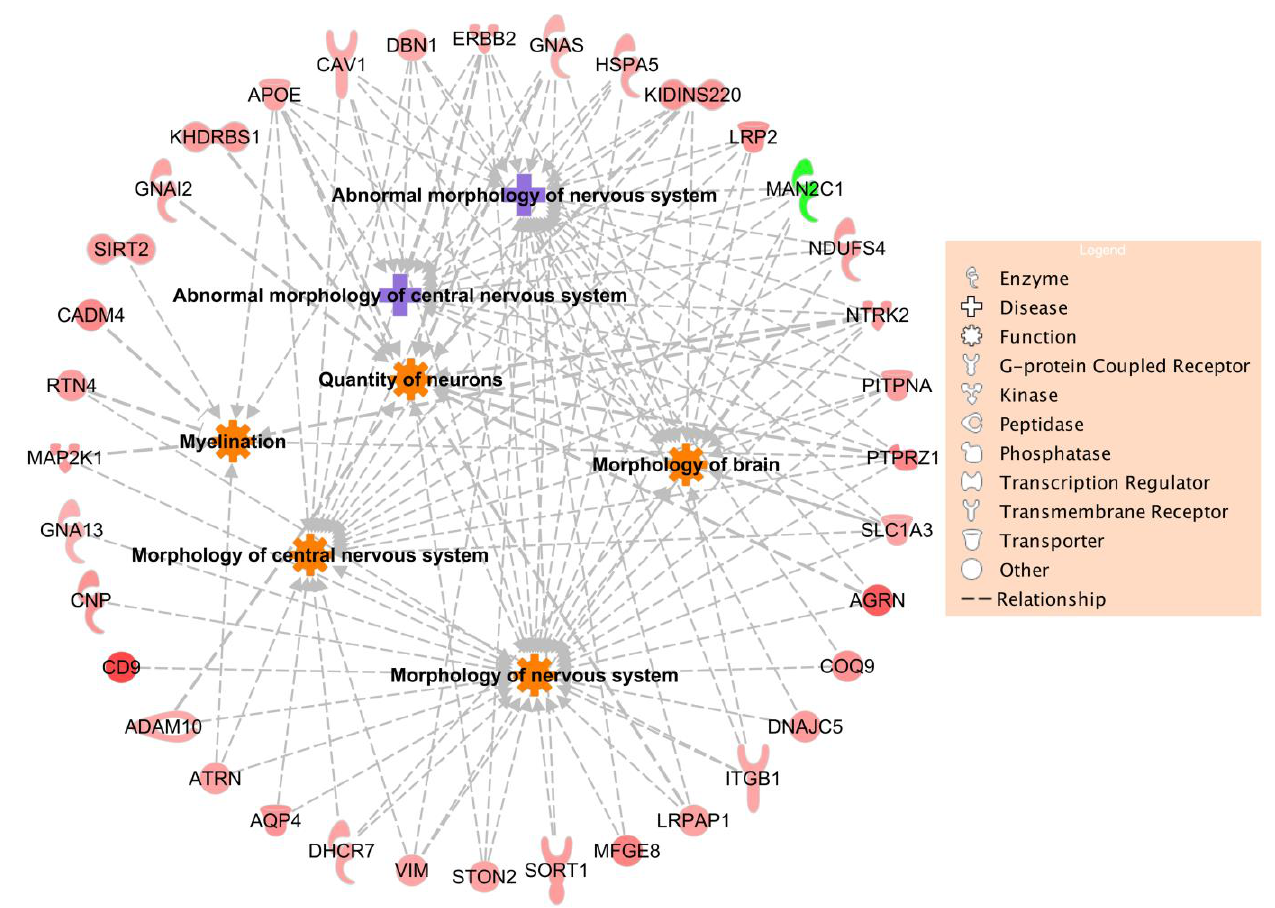
Figure 4. Differentially expressed proteins and their associations with multiple neurodevelopmental systems. Shapes of the molecules denote specific functions, such as G-protein coupled receptor, kinase, transcription regulator, and transporter.